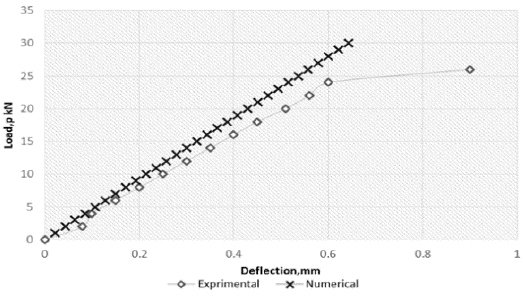
Figure 24. Load–deflection diagram of beam (B2).